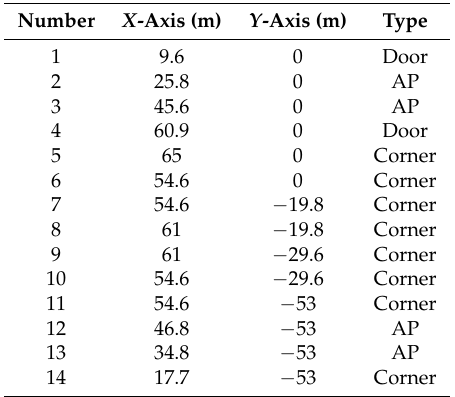
Table 1. Position of landmarks selected in the experiment.